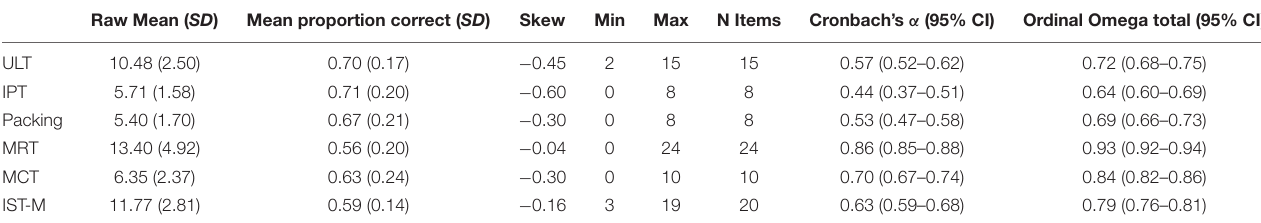
TABLE 1 | Descriptive statistics and reliability estimates of the study’s